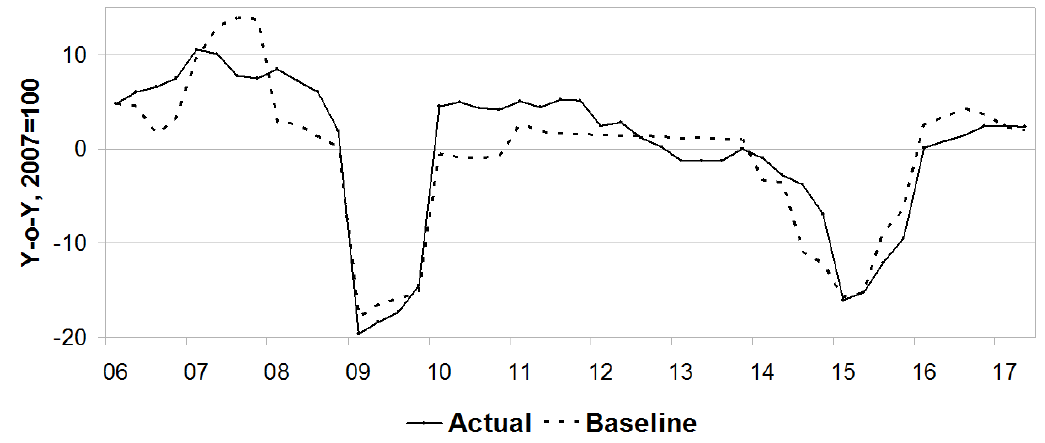
Figure 5. The comparative GDP dynamics based on actual data (Actual) and modeling results (Baseline)